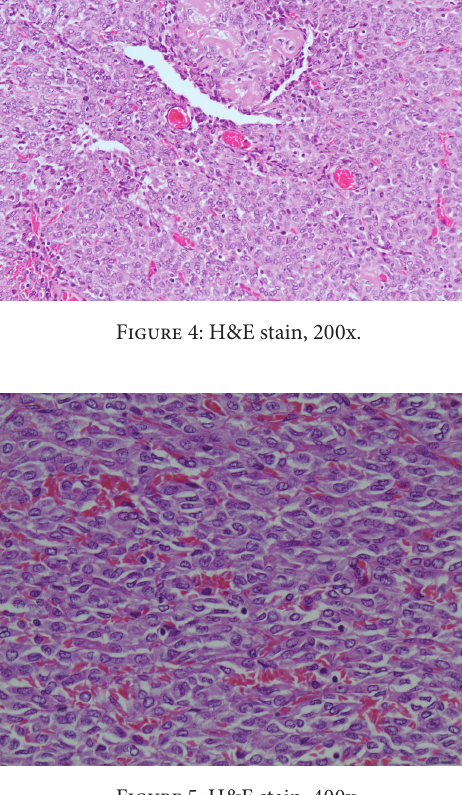
Figure 5: H&E stain, 400x.